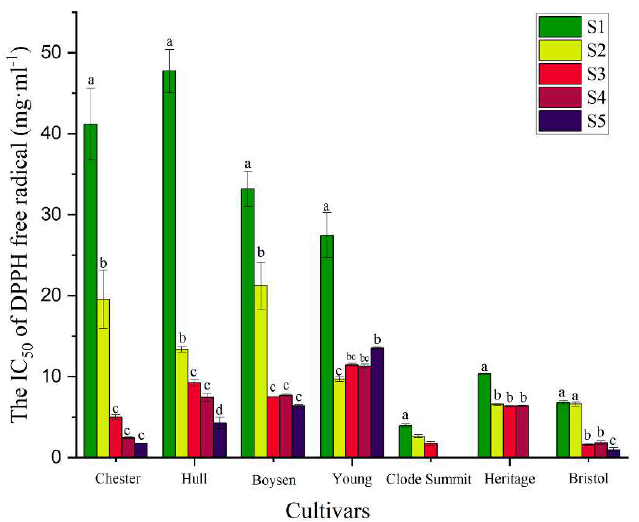
Figure 4. Variation in antioxidant activities. Different letters indicate significant differences between the populations ( p < 0.05). Different colors represent different periods of harvest.